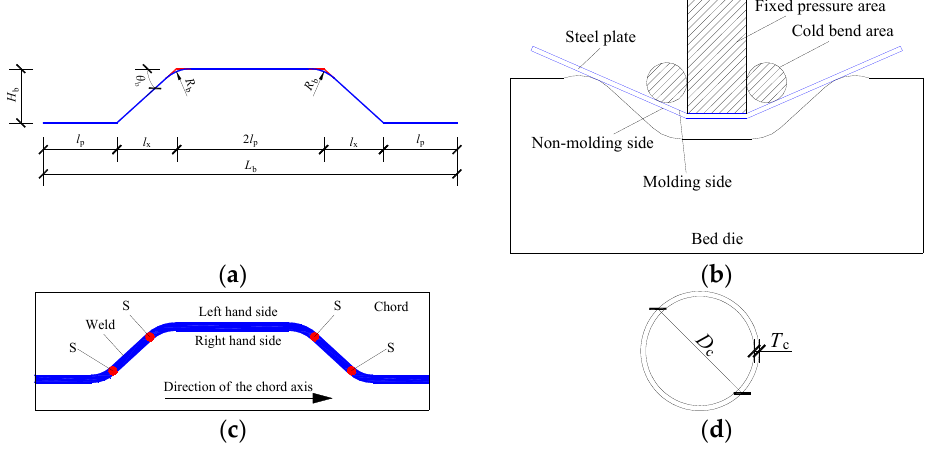
Figure 2. Parameters and craft of CSW: ( a ) parameters; ( b ) schematic of molding process; ( c ) schematic of intersecting welds; and ( d ) schematic of